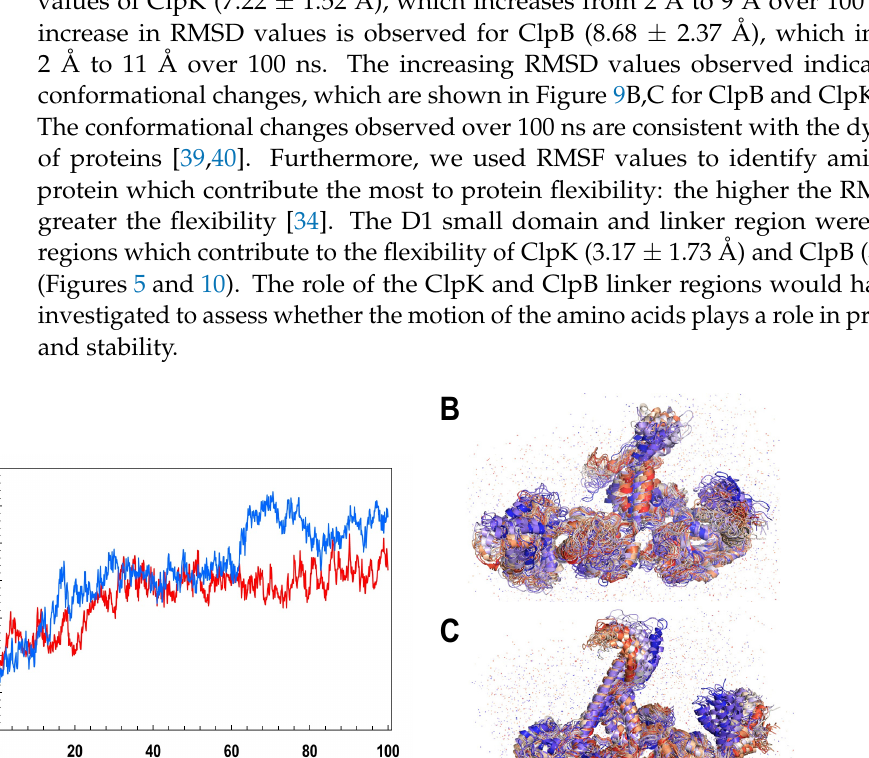
Figure 8. Potential energy profile of ClpK and ClpB during 100,000 ps molecular dynamic simulation. The potential energy for ClpK and ClpB is shown in red and blue, respectively. The image was generated using GraphPad prism.